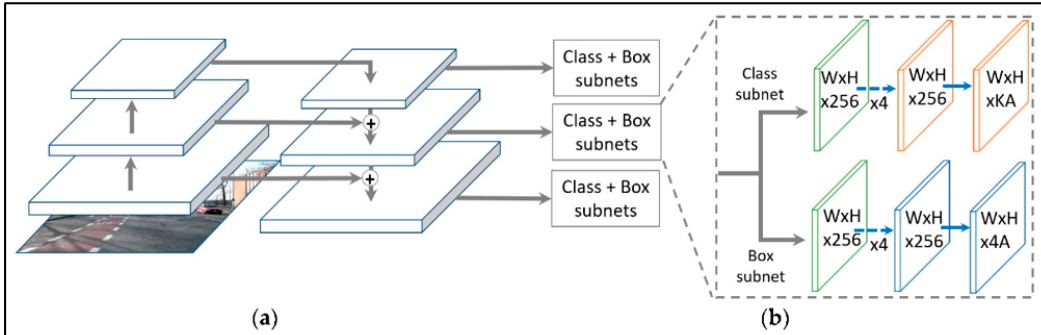
Figure 2. Architecture of RetinaNet: ( a ) first subnet and ( b ) second subnet .